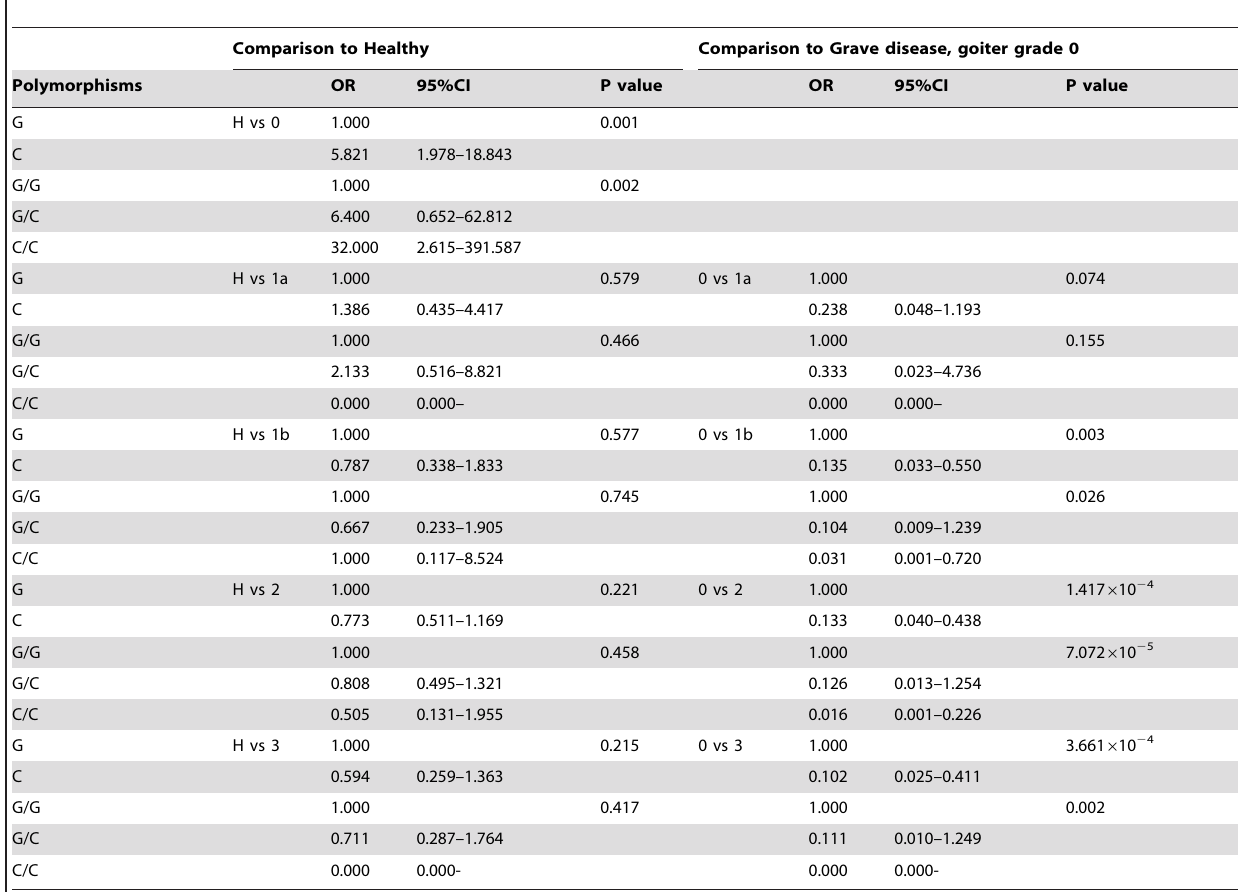
Table 4. Odds ratios of severity of goiter cases categorized by MIF polymorphism rs755622 in patients with untreated Graves